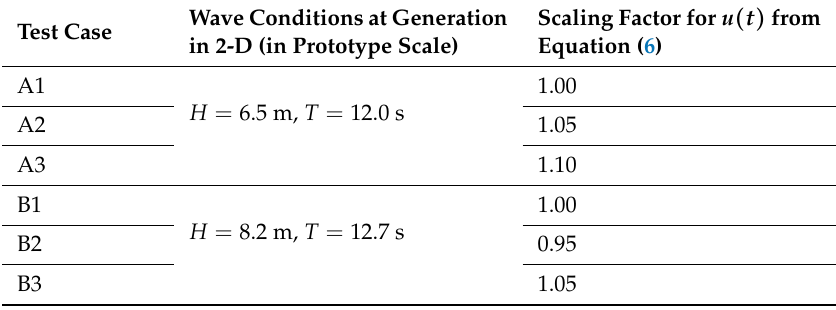
Table 2. 3-D test cases chosen for the Smoothed Particle Hydrodynamics (SPH)